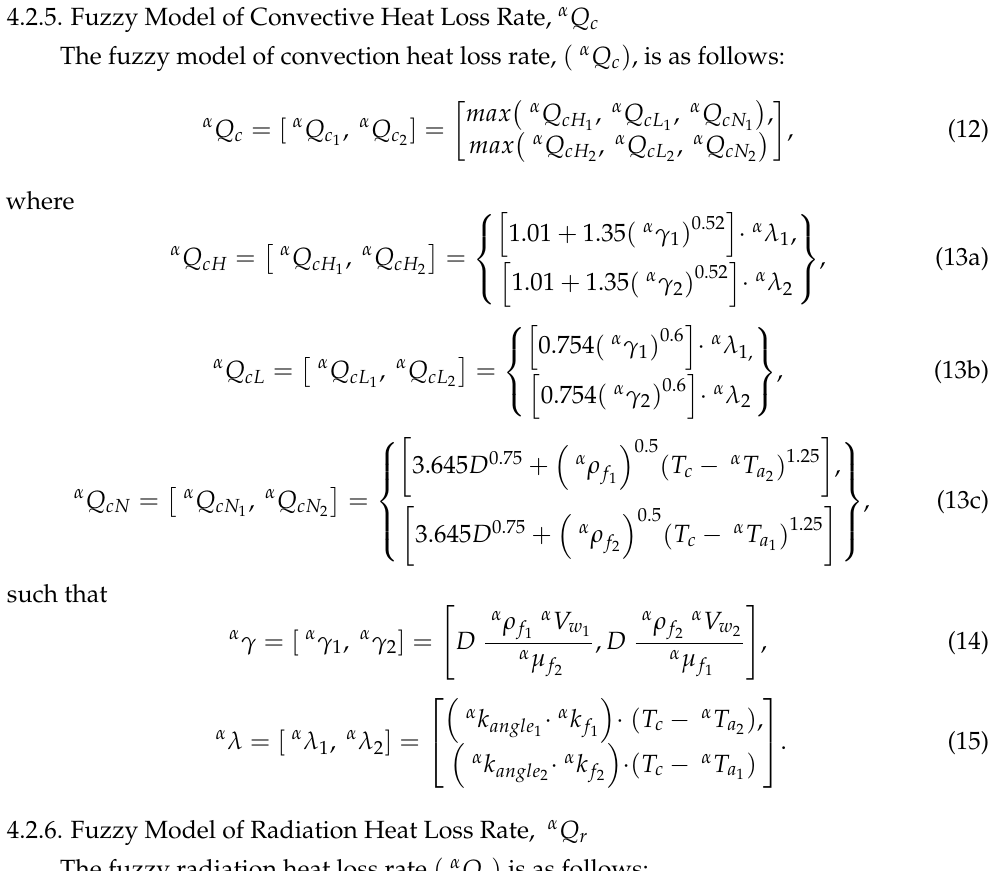
Figure 2. The range of fuzzy numbers is truncated within the crisp acceptable range.